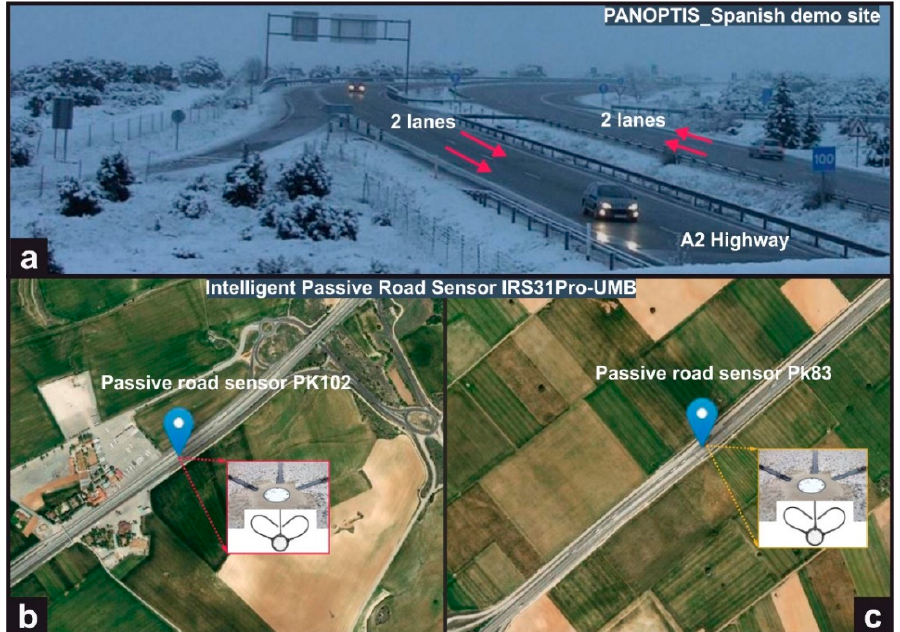
Figure 5. View of A2 Highway and zones where ice-sensors are installed in Spain. ( a ) View of the Spanish demo site (Guadalajara) A2-section 2 in between Madrid and Barcelona (modified from [96]). ( b ) A2 highway section where the PK102 ice-sensor is installed (shown in red color) (modified from Panoptis, 2021). ( c ) PK83 ice-sensor installed in a section of the A2 highway (shown in red yellow color) (modified from [95–98]).